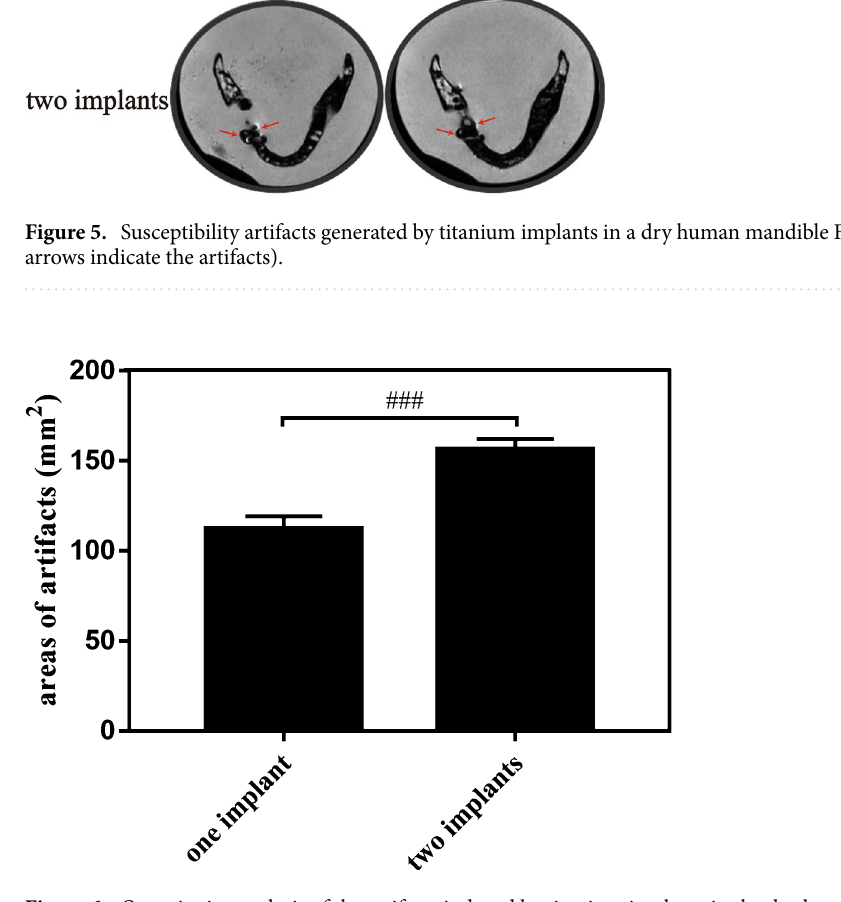
Figure 6. Quantitative analysis of the artifacts induced by titanium implants in the dry human mandible ( ### P ≤ 0.001 between each